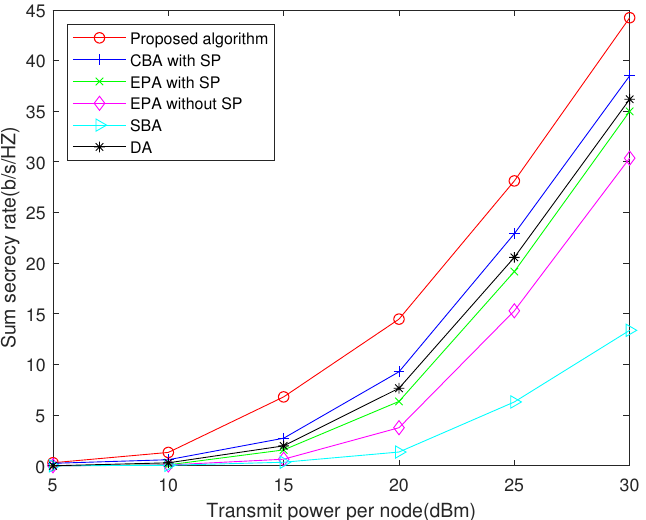
Figure 3. Sum secrecy rate versus transmit power per node when N =